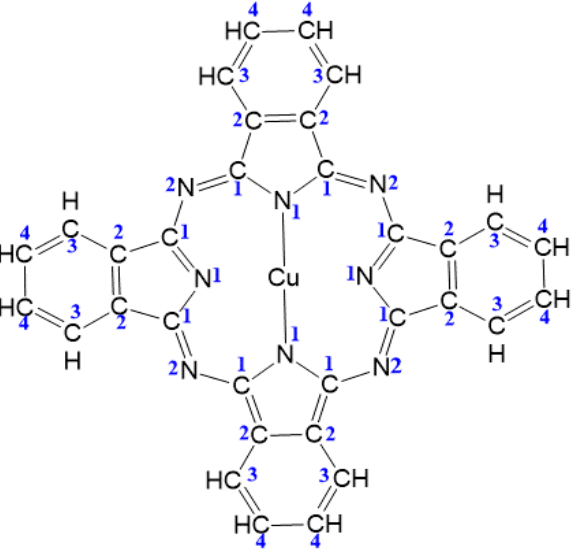
Figure 3. The structure of a copper phthalocyanine molecule. Table 3. The structures of some dyes corresponding to B-type writing inks. Common Names (C.I. Generic Name)